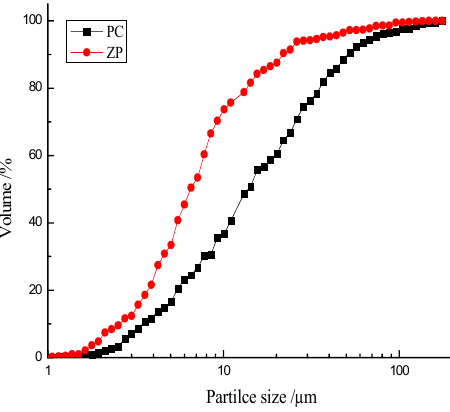
Figure 2. Particle size distribution curves of PC and ZP.